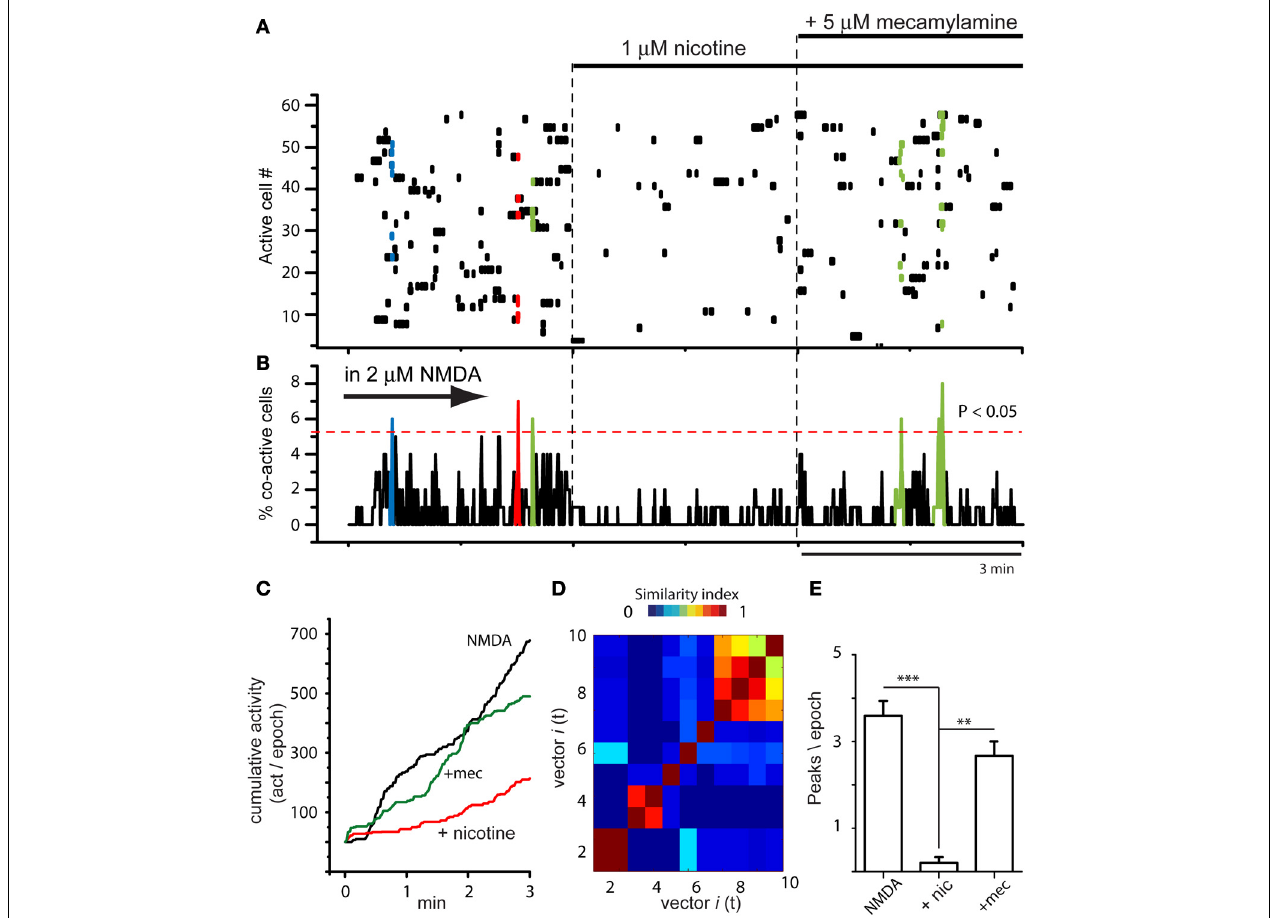
FIGURE 3 | Global actions of nicotine in the striatal circuit are blocked by mecamylamine. (A) Raster plot showing circuit activity in the presence of NMDA. Similarly to Figure 2A , left epoch shows activity with spontaneous synchronization of different neuron pools (colored dots). Middle epoch: nicotine (1 μ M) added to the bath saline in the presence of NMDA induced a decrease in activity and the absence of color indicates that significant events of spontaneous synchronization are now absent. Right epoch: addition of 10 μ M mecamylamine allowed the return of some peaks of synchronization showing that the activity of nicotine was receptor dependent ( n = 3 slices; 6 epochs). (B) Activity histogram displaying multicellular activity from the raster plot above. Significant peaks of synchronization (colored) appear during NMDA. They disappeared when